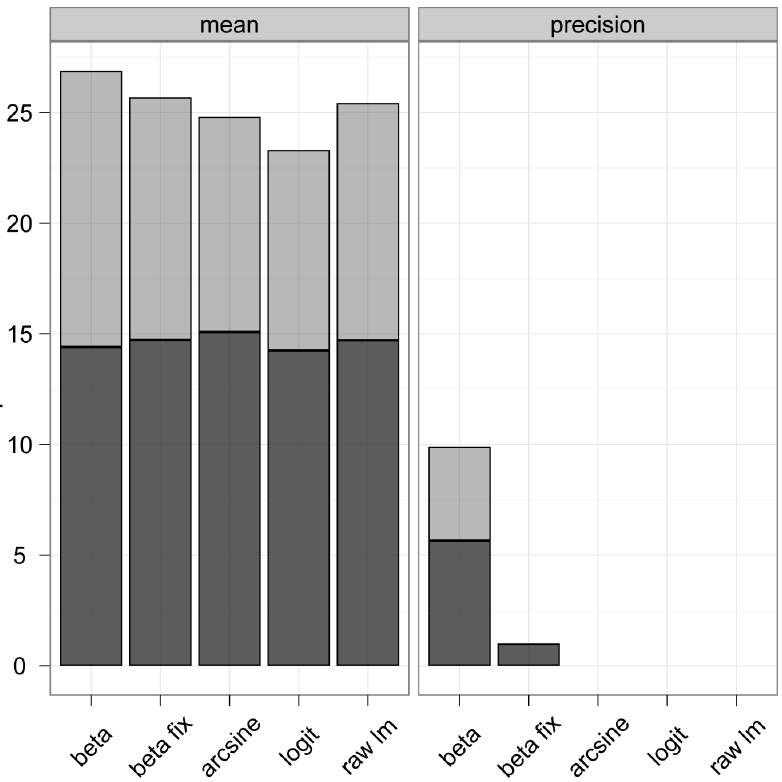
Figure 5. Number of selected predictor variables. Analysis of the NLA Data. The two panels contain the number of selected predictor variables (averaged over 100 bootstrap samples) for various modeling approaches. Dark grey bars represent linear effects, light grey bars represent non-linear effects. In case of beta regression with fixed precision parameter (‘‘beta fix’’), the precision model contains only one predictor (namely, the intercept).